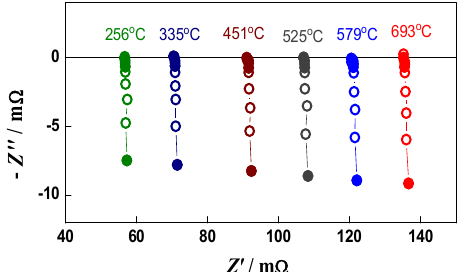
Figure 2. Impedance diagrams during cooling of the reduced bare anode.